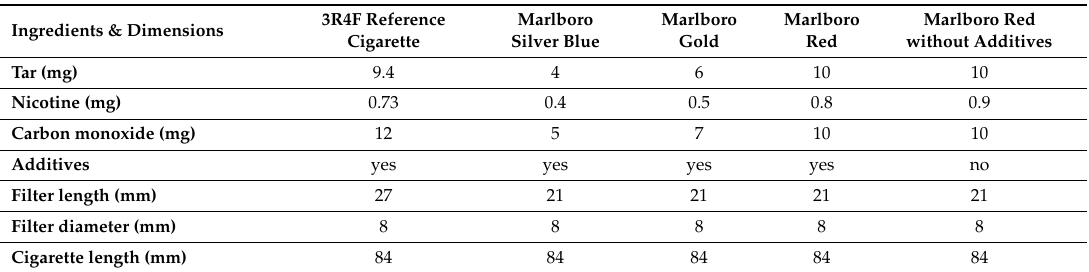
Table 1. Characteristics of the investigated cigarette types: The amounts of tar, nicotine, carbon monoxide, the presence of additives, and the dimensions of filter and cigarette are shown. Ingredients &